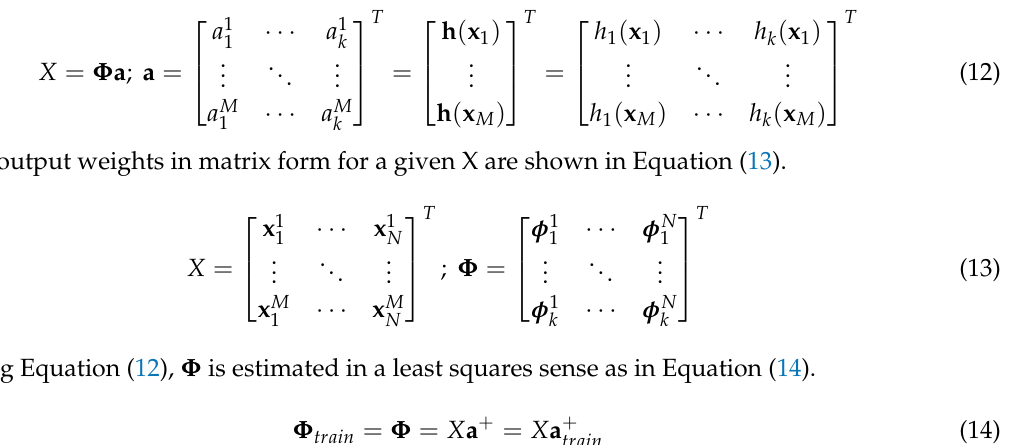
Figure 1. Schematic of the extreme learning machine (ELM) autoencoder network. In this architecture, the output features are the same as input